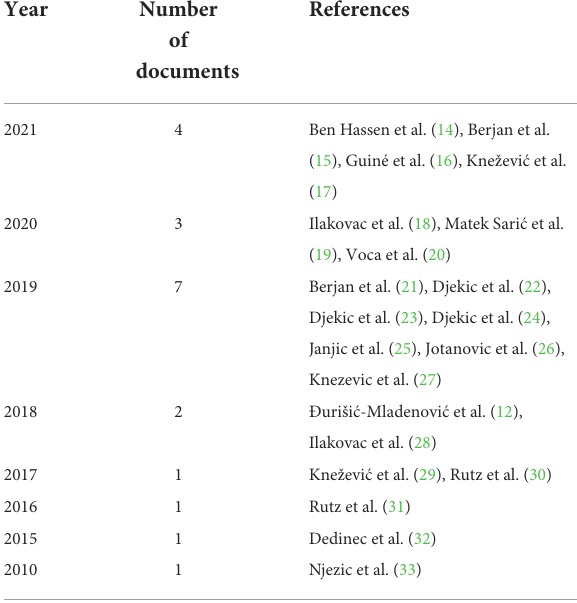
TABLE 1 Documents considered in the systematic